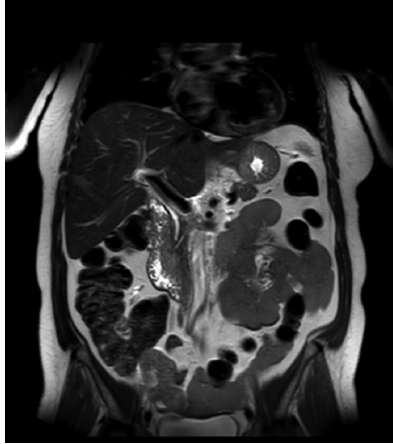
Figure 1. Coronal T2-weighted MR image showing a broad-based lesion at the ampulla. MR, magnetic resonance.